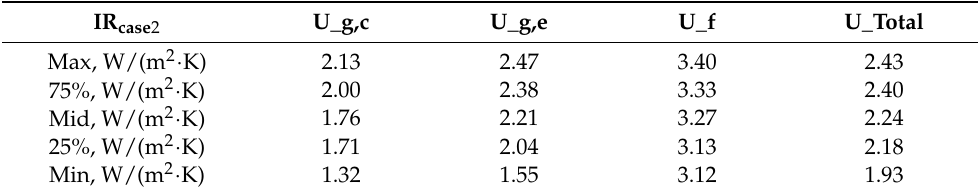
Table 8. Window U-values using the IR case2